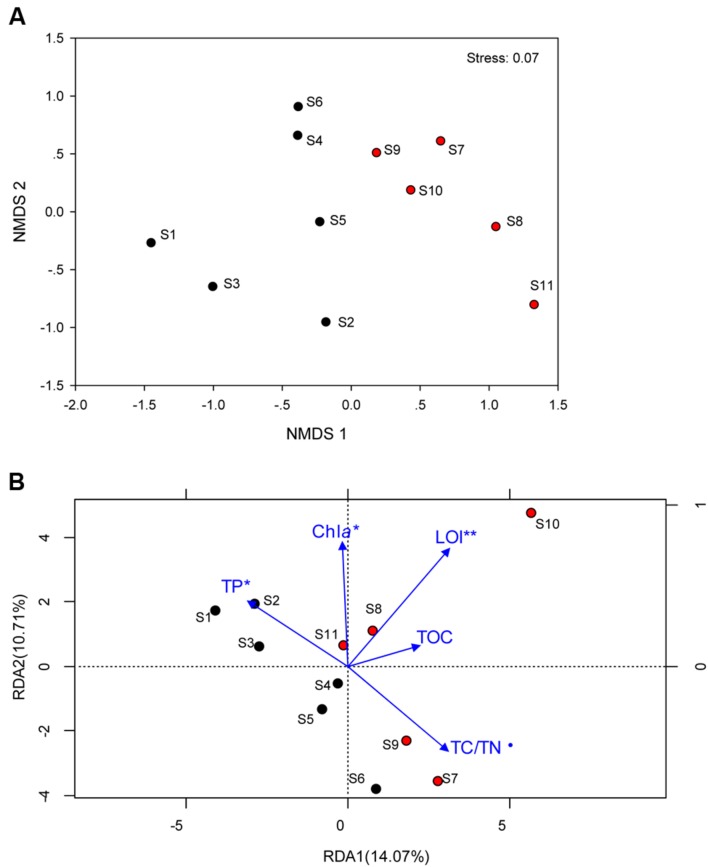
(A) Non-metric multidimensional scaling ordination (NMDS) plot of the archaeal communities; (B) Redundancy analysis (RDA) of the archaeal community composition with sediment physichemical charateristics (blue arrows) for the 11 sampling sites. Samples in the cyanobacteria-dominated zone was marked by black filled cycles; Samples in the macrophyte-dominated zone was marked by red filled cycles; those physichemical charateristics which are significant correlation with the dynamics of archaeal were marked with ⋅ for 0.1 level, ∗for 0.05 level and ∗∗ for 0.01 level.